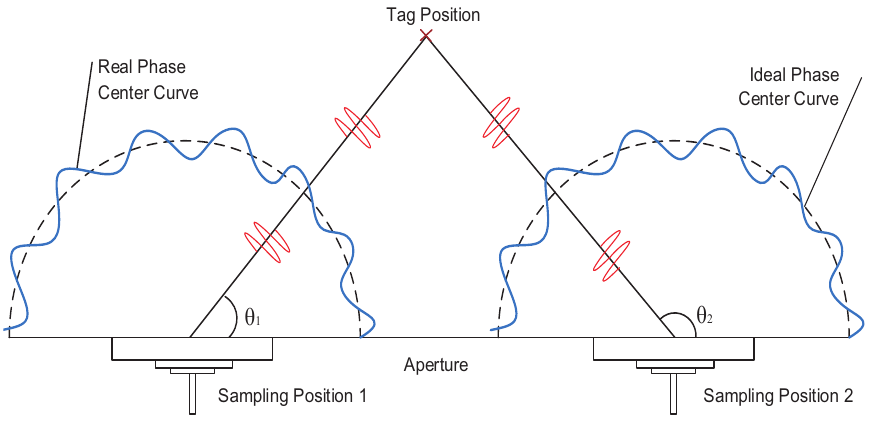
Figure 7. Antenna phase center offset related to